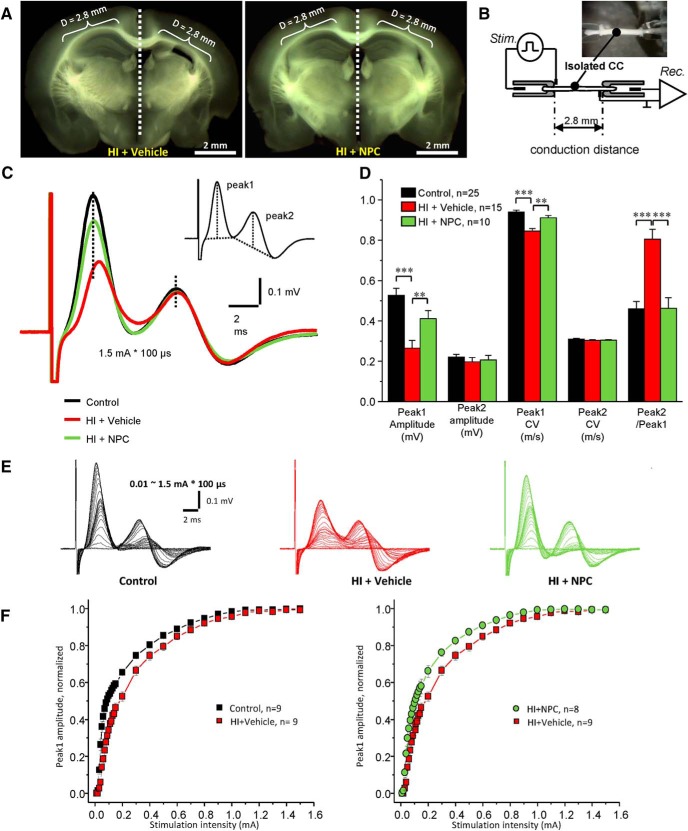
NPCs contribute to myelination after transplantation (electrophysiology). A, Electrophysiological properties of the CC from HI + Vehicle (n = 15) and HI + NPCs (n = 10) mice: coronal slices (400 µm) of a HI (left side) and HI + NPCs (right side) from HI mice brains. B, Diagram of the suction electrode recording method. The conduction distance of CC was 2.8 mm. C, Averaged CAP traces recoded from left/control side of the CC (n = 15 + 10, black line), right/injured side of the CC (n = 15, red line) and right/injured side of the CC after NPC transplantation (n = 10, green line), respectively. Inset: the measurement of CAP amplitudes. D, Detailed statistical comparison of CAP parameters from left/control CC (black bars), right/injured CC (red bars), and right/injured CC after transplantation (green bars). Conduction velocity (CV) calculated through the recording distance (2.8 mm) divided by the time between artifact and peak. E, Relationship between stimulus intensities and amplitudes of CAPs: representative superimposed CAPs recorded at varying stimulus intensities (0.01∼1.5 mA) from left/control CC (left traces), right/injured CC (middle traces), and right/injured CC after NPC transplantation (right traces). F, Comparison of the stimulus–response relationship of peak1 between left/control CC and right/injured CC (left plot, black and red, respectively); between right/injured CC with or without NPC treatment (right plot, red and green, respectively). All recordings were performed at room temperature. *p < 0.05, **p < 0.01, ***p < 0.001.